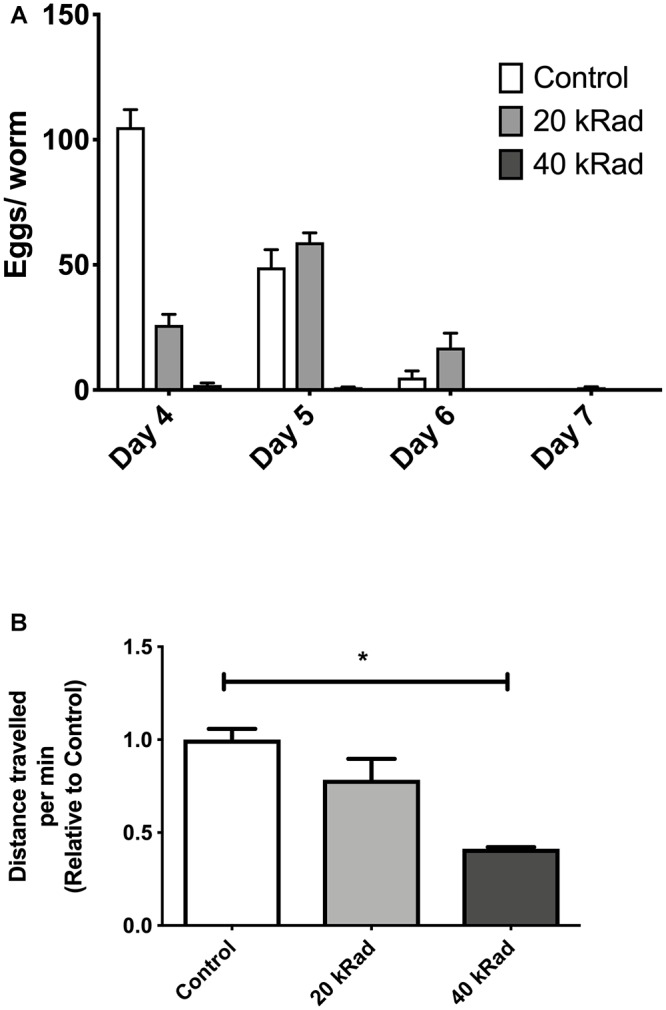
Pilot experiments of various doses of γ-radiation. (A) Egg-laying study comparing number of eggs laid by C. elegans exposed to 0 (control), 20 and 40 kRad γ-radiation doses. Animals exposed to γ-radiation laid less eggs than non-irradiated control animals. (B) Distance traveled by C. elegans exposed to 0 (control), 20 and 40 kRad γ-radiation doses. Non-irradiated animals were healthy and active. Animals exposed 40 kRad of γ-radiation explored less than 20 kRad and control.